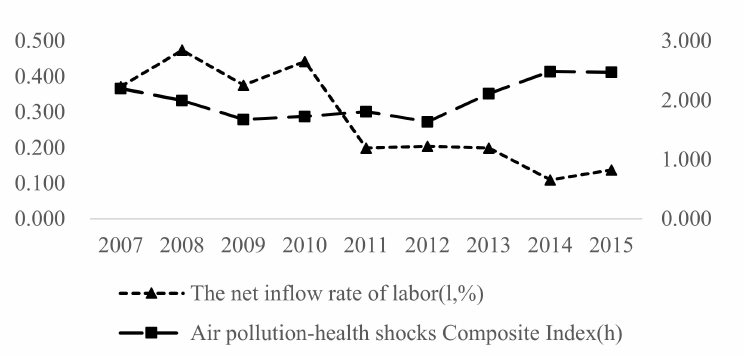
Figure 2. The trend of the net inflow rate of labor mobility and the air pollution-health shocks composite index from 2007 to 2015. Note: (1) The net inflow rate of labor mobility is calculated according to Formula (7) below, which is the average value of each year. (2) The air pollution-health shocks composite index is calculated in Section